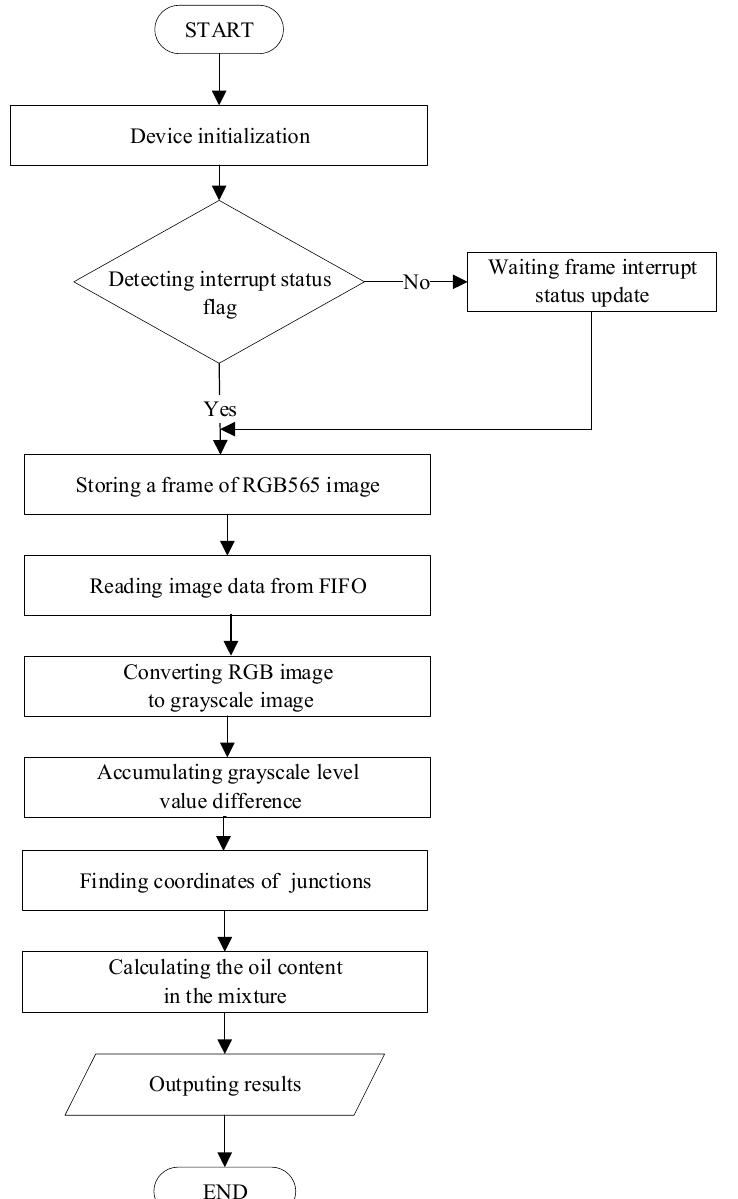
Figure 7. Diagram of the proposed method.